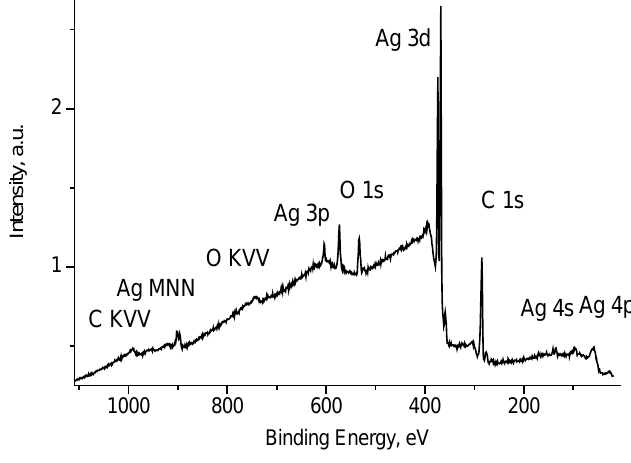
Figure 4. X-ray photoelectron spectroscopy (XPS) survey spectrum of Ag black.